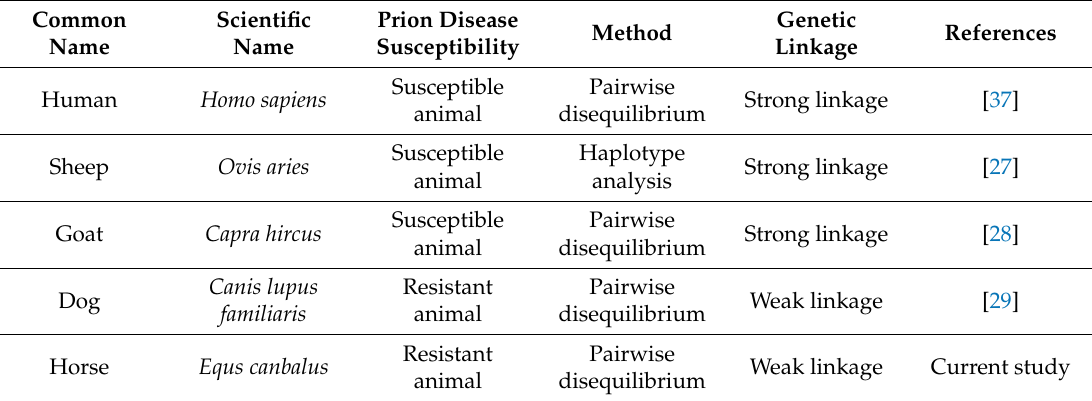
Table 7. Genetic linkage between PRNP and PRND genes in several